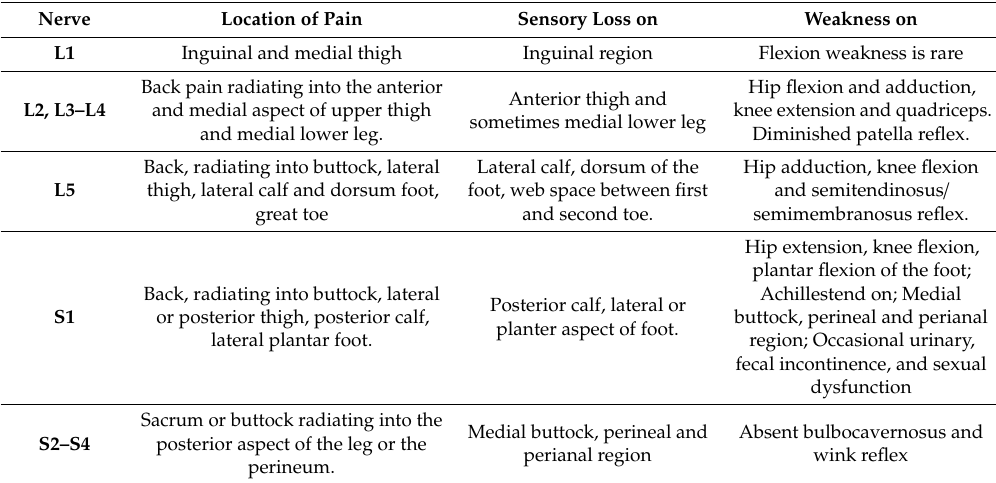
Table 2. Location of pain, sensory loss, and weakness in association with compression of nerve roots during lumbar herniated